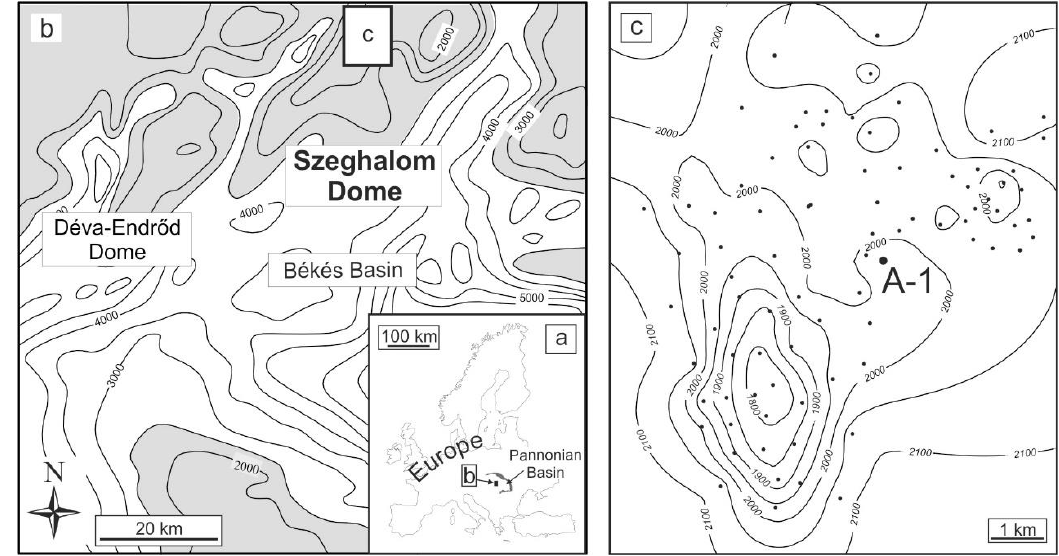
Figure 1. Sketch of the study area. ( a ) Position of the Pannonian Basin in Europe. ( b ) Subsurface topographic map of the SE part of the basement of the Pannonian Basin. Isolines denote depth (in m) below the present surface (m). ( c ) Topographic map of the Szeghalom metamorphic dome. Dots represent wells reaching the basement of the Pannonian Basin.